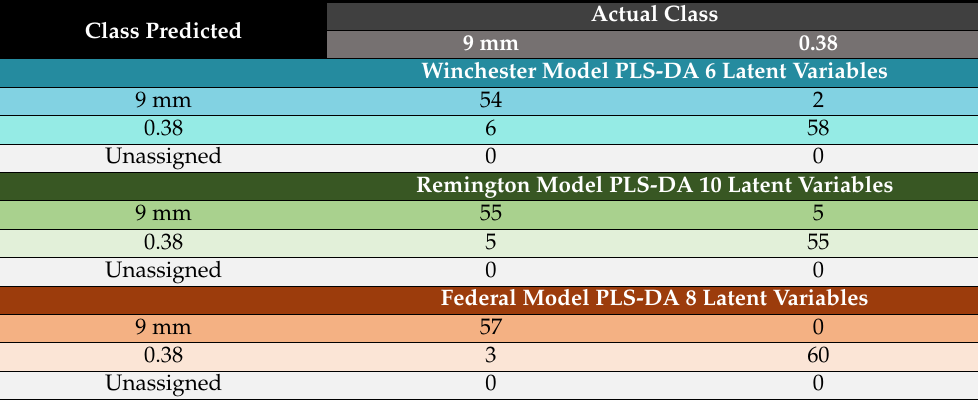
Table 5. The spectral classification results from three distinct PLS-DA models for caliber differentia- tion within each of the three manufacturer sample classes.